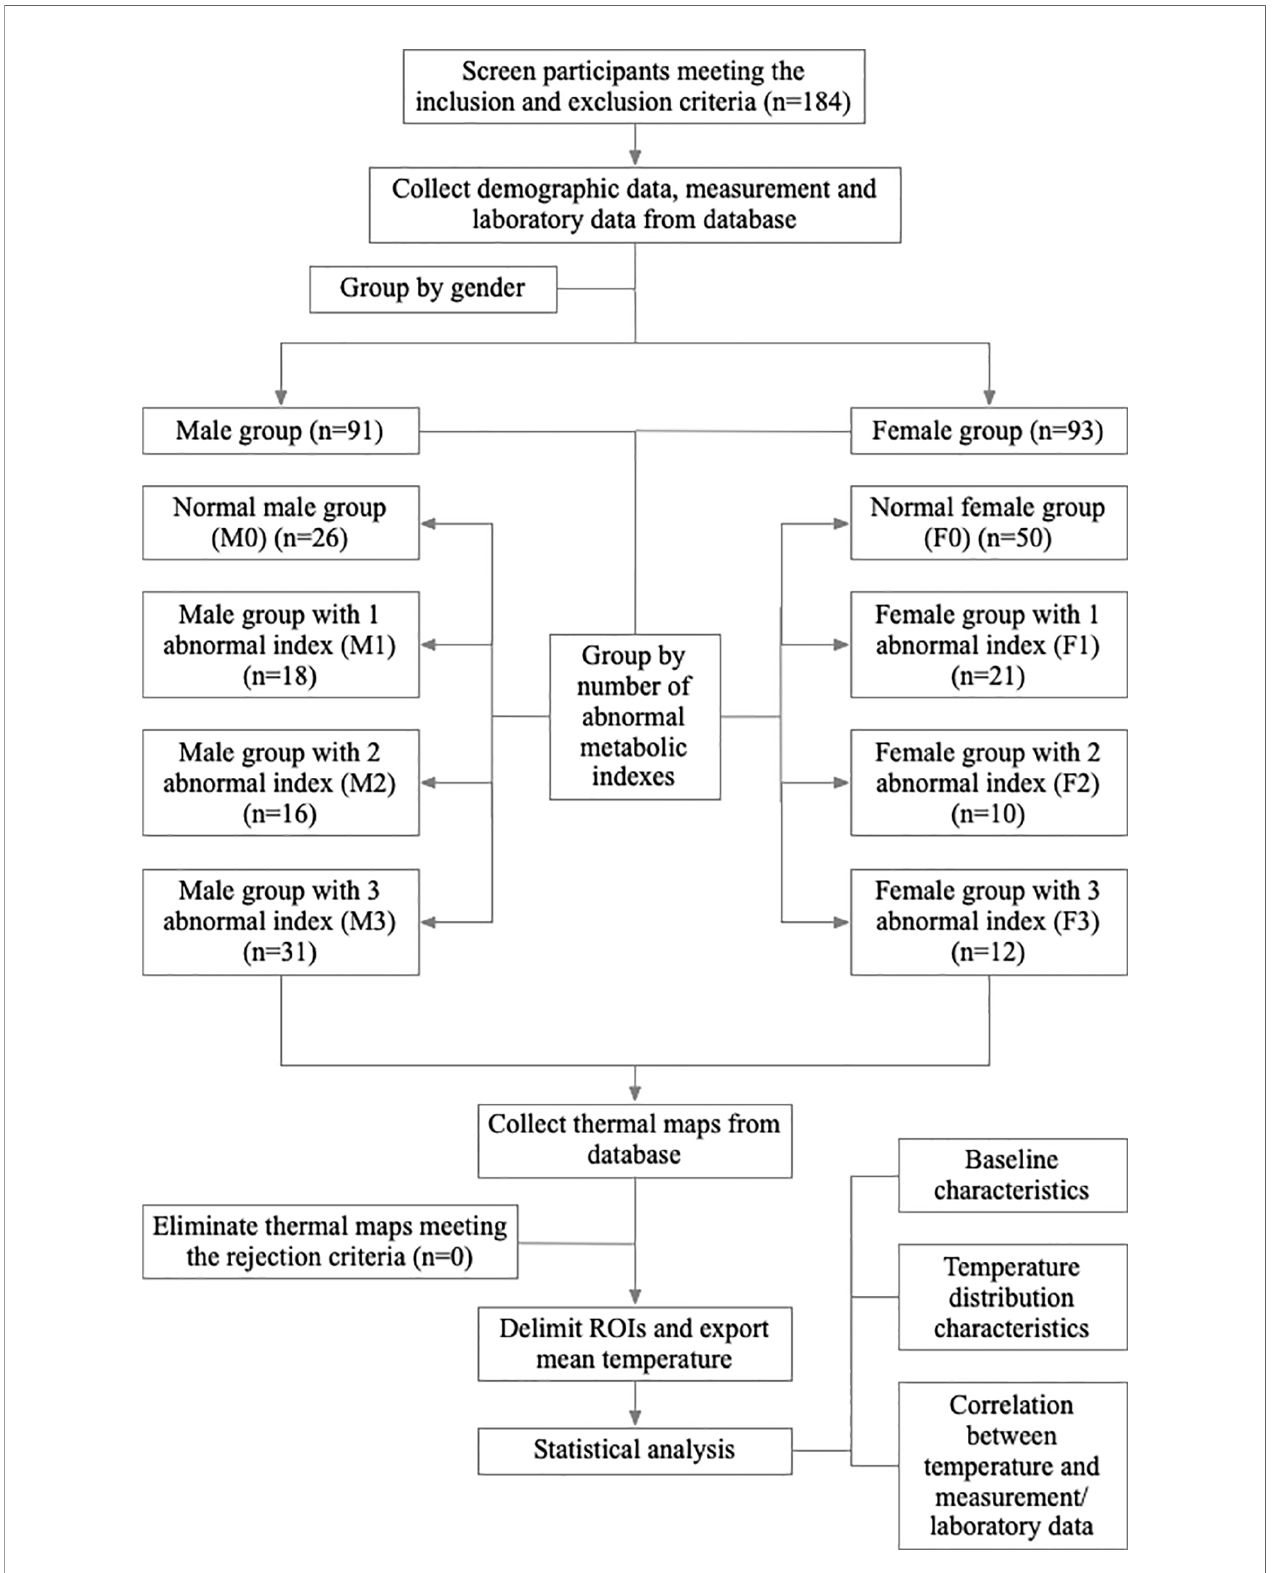
FIGURE 2 | Study fl ow